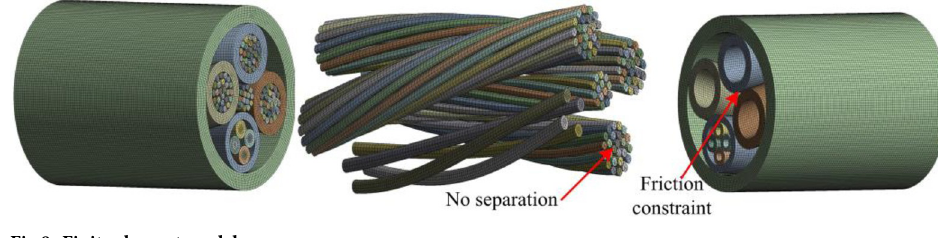
Fig 8. Finite element model.